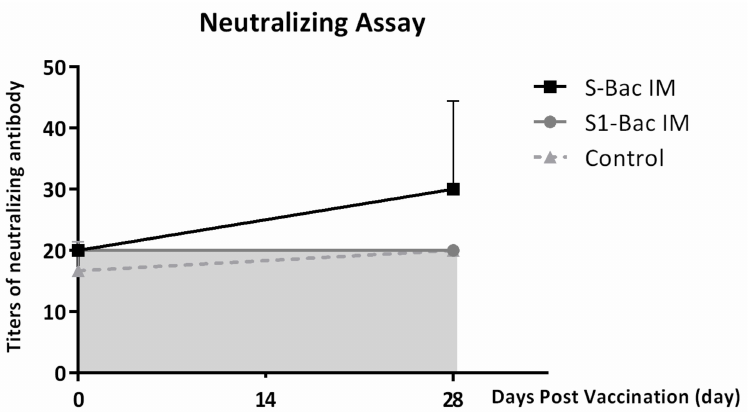
Figure 5. The neutralizing titers of systemic antibody of mice in control, S-Bac and S1-Bac groups at day 0 (pre-priming) and day 28 (2 weeks post-boosting). The shift of neutralizing titers of S-Bac and S1-Bac vaccinated mice are represented as a solid line with square icons and a gray line with round icons, respectively. The neutralizing titers in the blood of control mice are labeled with triangle icons on a dotted line. The error bars represent the SD values of each group at different time points. The background of this neutralizing assay was 1:20, and the area under detection background is marked as a gray